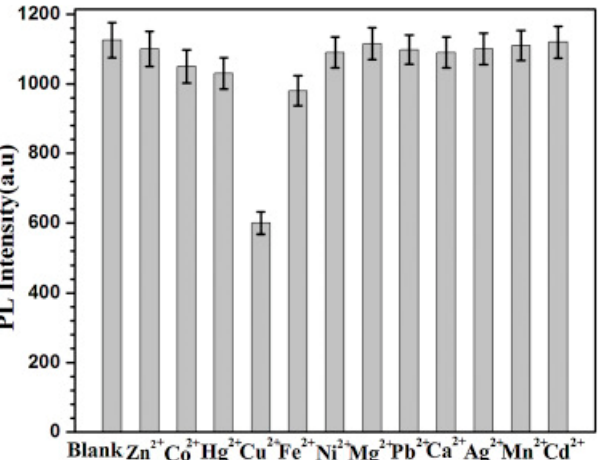
Figure 6. PL quenching reported by Gedda et al. [99] in presence of different metal ions with a concentratin of up to 5 μ M. Picture reprinted with all permissions from Elsevier.